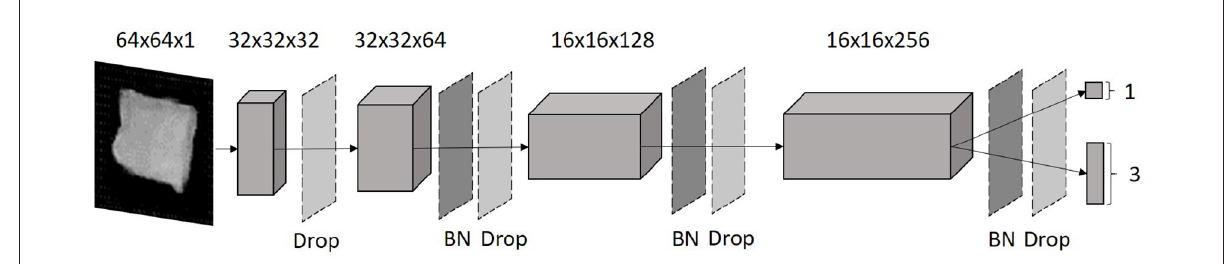
FIGURE4 Discriminator architecture. The input layer is reduced using four fully linked convolutional layers. In between, batch normalization (BN) and a dropout (D) were used to make the discriminator more stable. As a result the discriminator distinguished whether the input image is real or fake and at the same time determined the associated label.